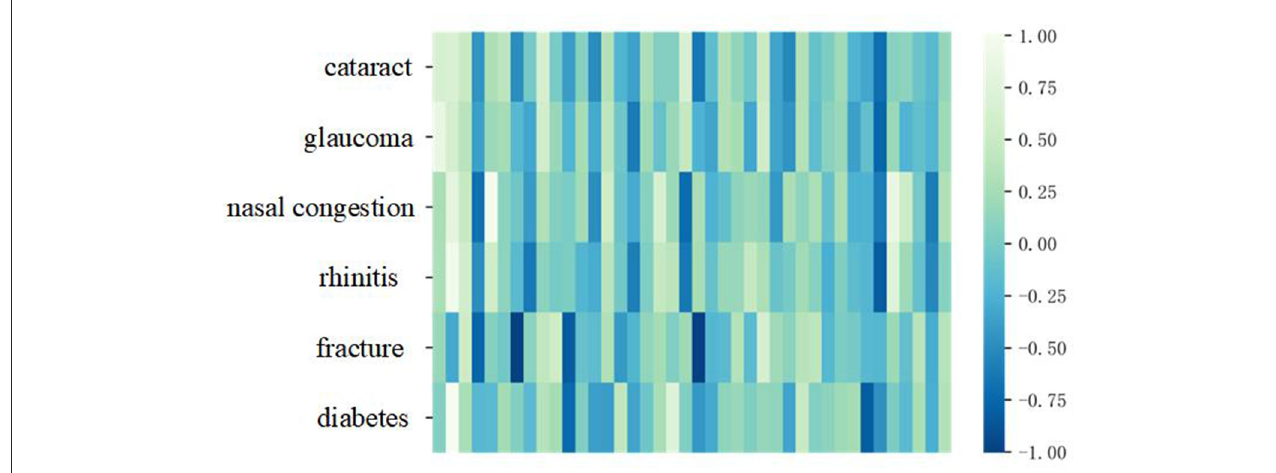
FIGURE3 The result of pre-training word vector.